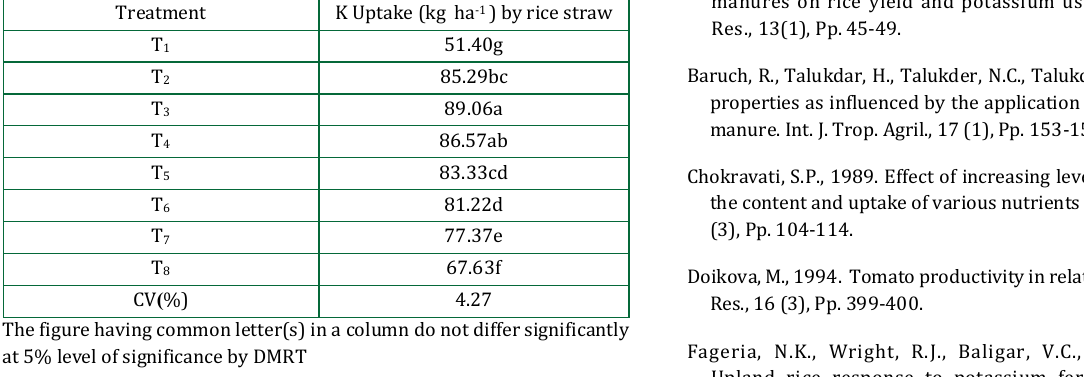
Table 5: Potassium uptake in rice straw of BRRI dhan49 as influenced by Banana leaves and chemical fertilizers Treatment